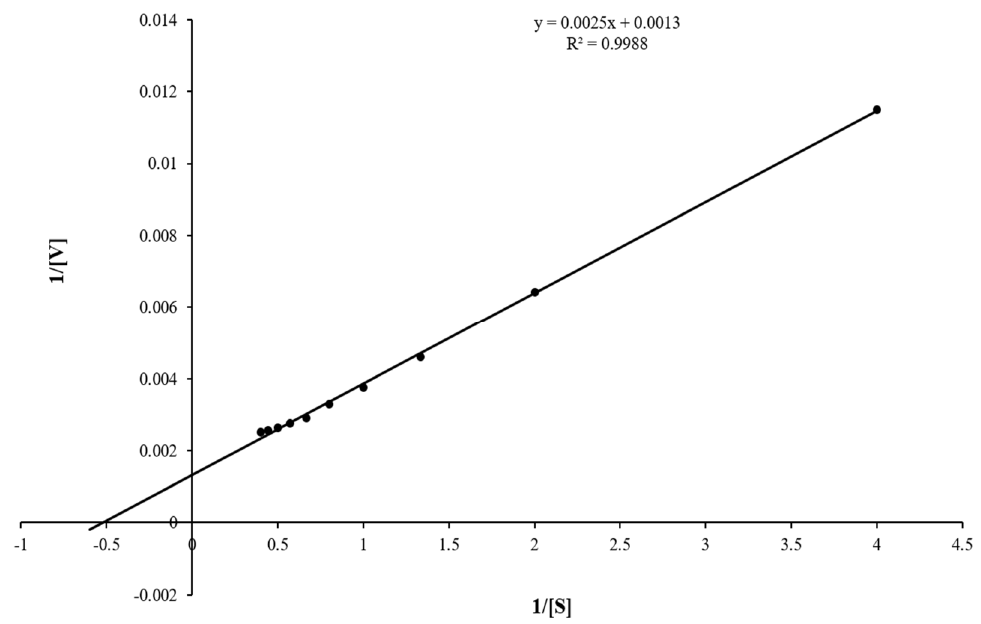
Figure 5. Lineweaver–Burk plot of purified xylanase from Bacillus paramycoides T4. Table 4. Effect of metal ions on enzyme activity and